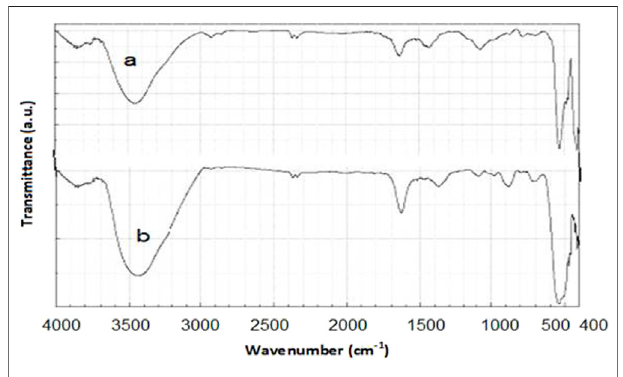
FIGURE 4 | FTIR spectroscopy of (A) synthesized and (B) commercial ZnO.